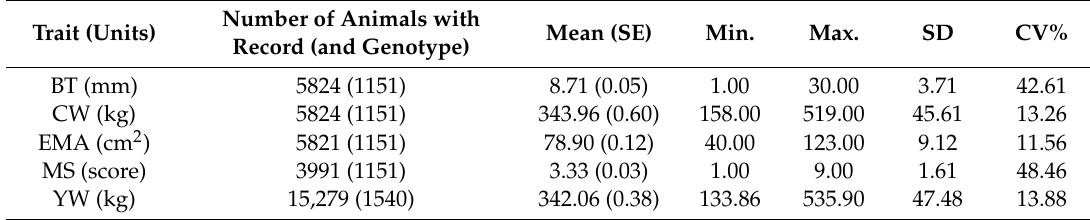
Table 1. Summary statistics for phenotypic data used to estimate variance components in Hanwoo cattle. Trait